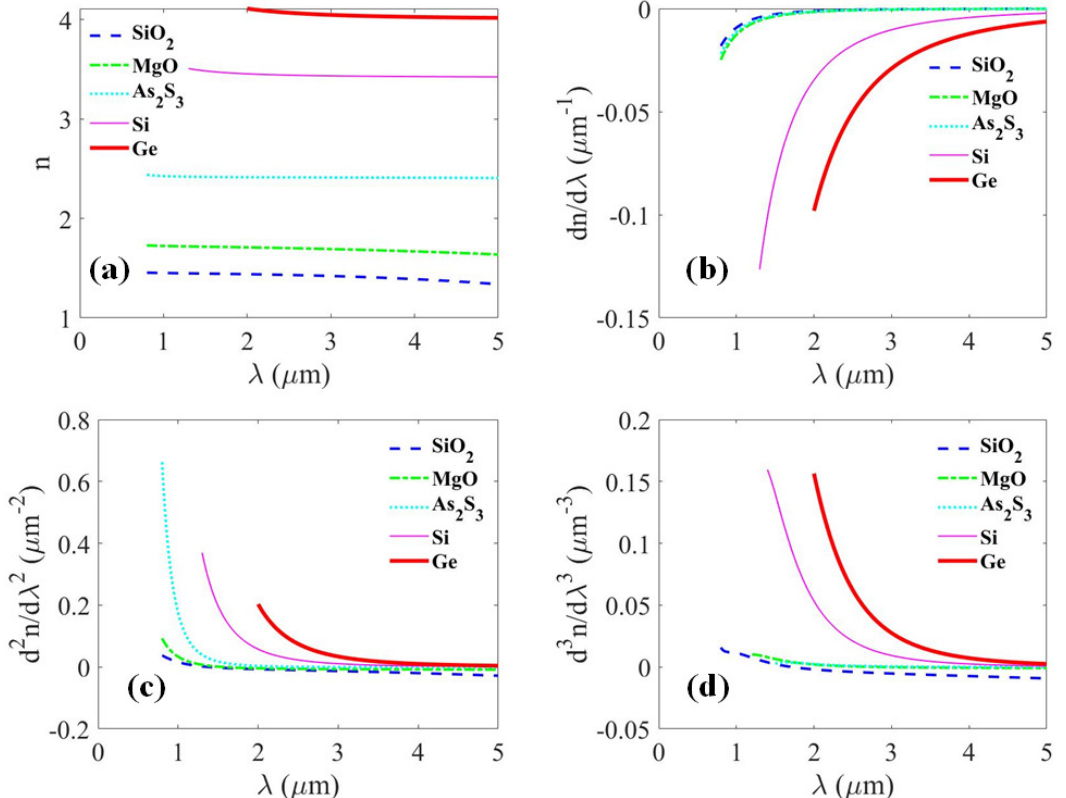
Figure 2. Refractive indices and dispersion properties of typical infrared materials: ( a ) Refractive index, + n = A + B λ 2 − 0.028